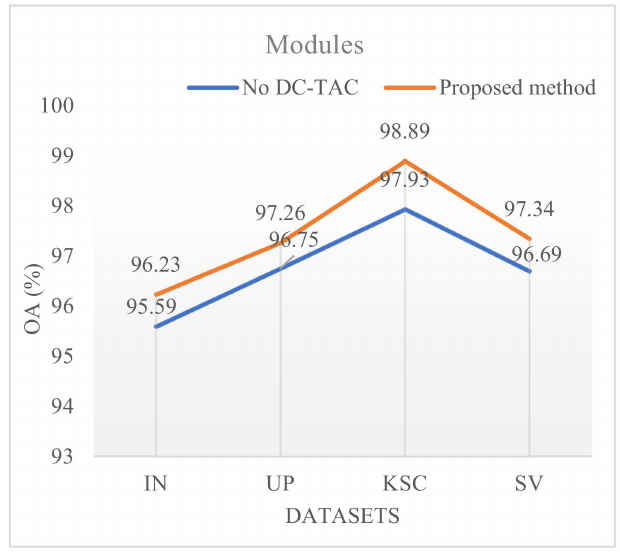
Figure 13. OAs with different feature extraction modules on IN, UP, KSC, and SV datasets (%).